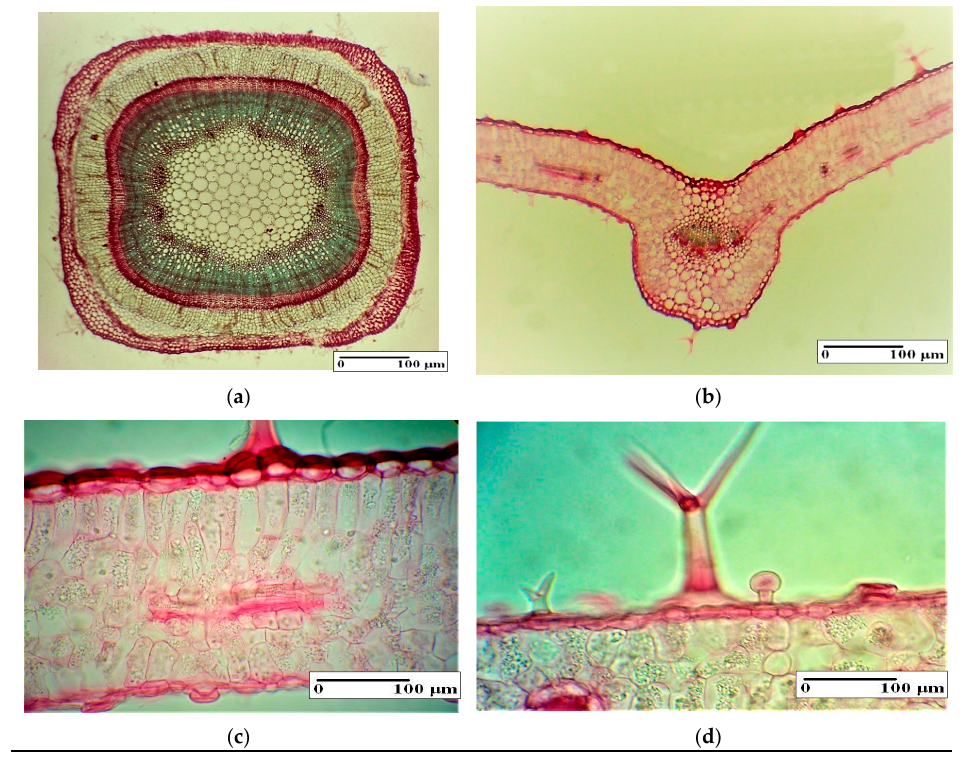
Figure 2. The general aspects of internal structure of Lavandula angustifolia Mill. vegetative organs: stem ( a ), main string of leaf ( b ), leaf lamina ( c ) and leaf lamina with protective and glandular trichomes ( d ).